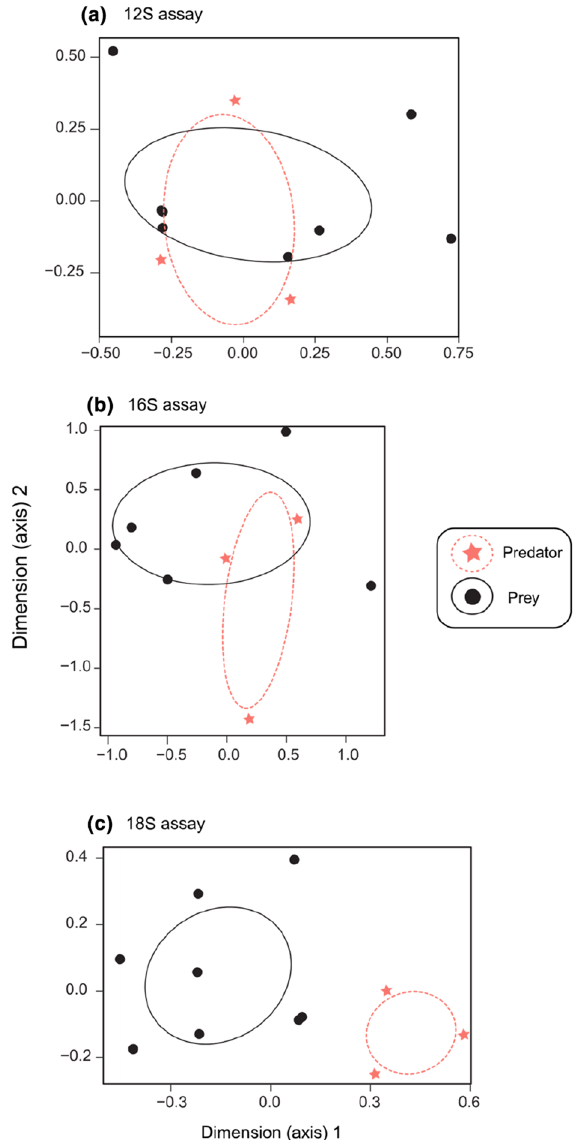
Figure 3. Kruskal’s non-metric multidimensional scaling (NMDS) plots of stomach-content metabarcoding assays for predators ( S. mokarran ; dotted lines and stars) vs. that of their whole prey ( Urolophus sp. and A. rostrata ; solid lines and circles), ( a ) 12S, ( b ) 16S, and ( c ) 18S assays, based on taxon and number of reads. For comparison, NMDS with stable solution from random starts showed the same pattern (not presented). Predator and prey comparisons based on taxon presence/absence only showed no significant differences for all three assays (not presented) ( p > 0.05).